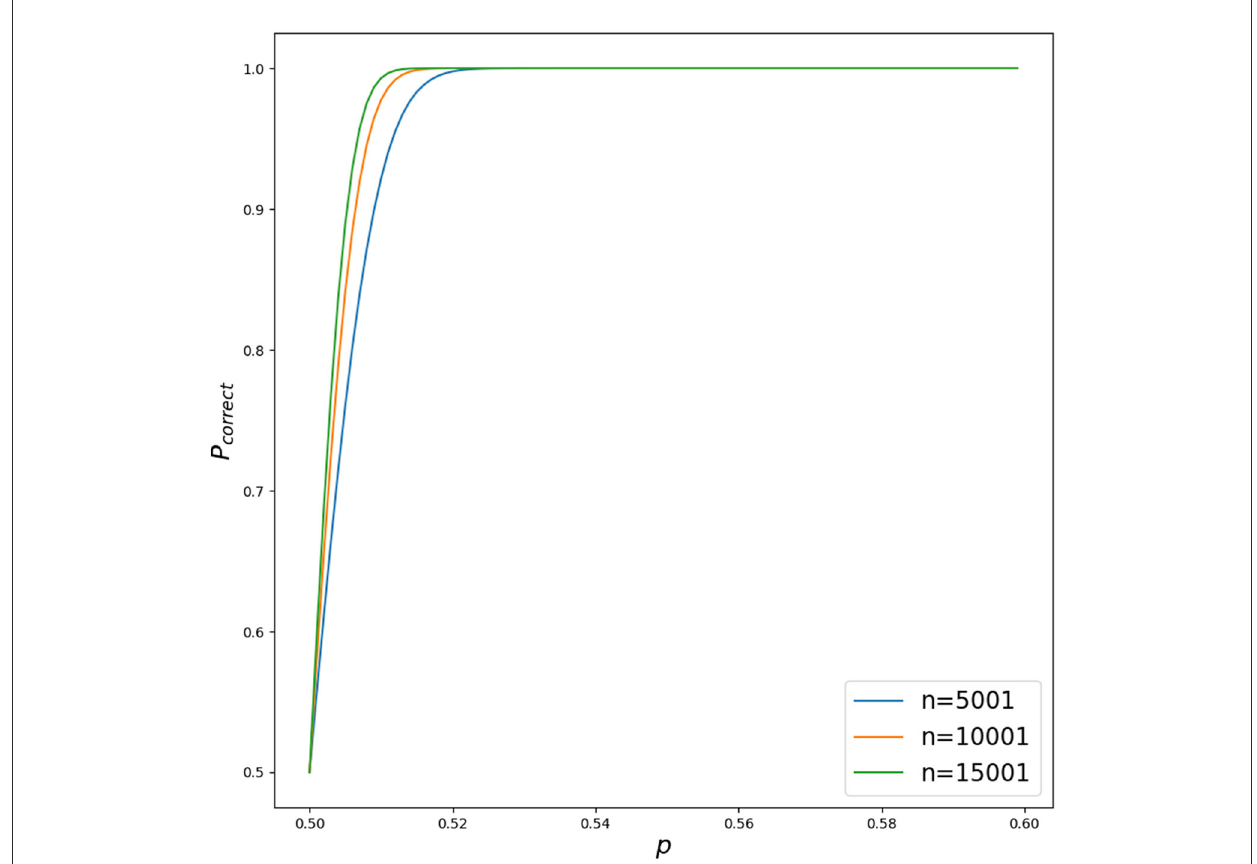
FIGURE5 Different outcomes for P correct for different p ∈ [0.5,0.6] with increasing n for n ∈ { 5001,10001,15001 } . Python script is in Appendix